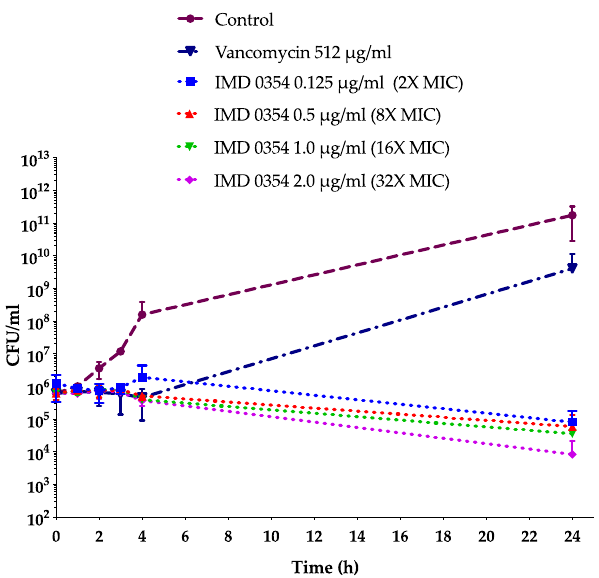
Figure 2. Time-killing curve shows IMD0354 is bacteriostatic against vancomycin-resistant strain VRS1. In total, 10 6 CFU / mL of VRS1 overnight culture was treated with various concentrations of vancomycin and IMD0354. At times of 1, 2, 3, 4, and 24 h, samples we collected, serially diluted, and spot-plated in order to enumerate CFU / mL. Each sample was tested in triplicate. ( n = 3, ±